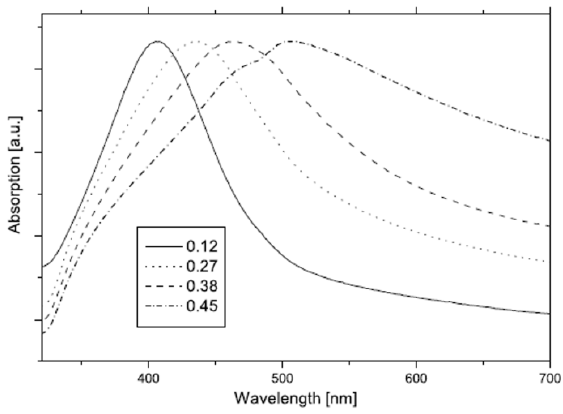
Figure 8. UV-Vis spectra of Ag/polytetrafluoroethylene nanocomposite systems at increasing values of the metal volume filling factor f . The inset indicate the metal volume filling factor value. (Reproduced with permission from [47], Copyright IOP Publishing